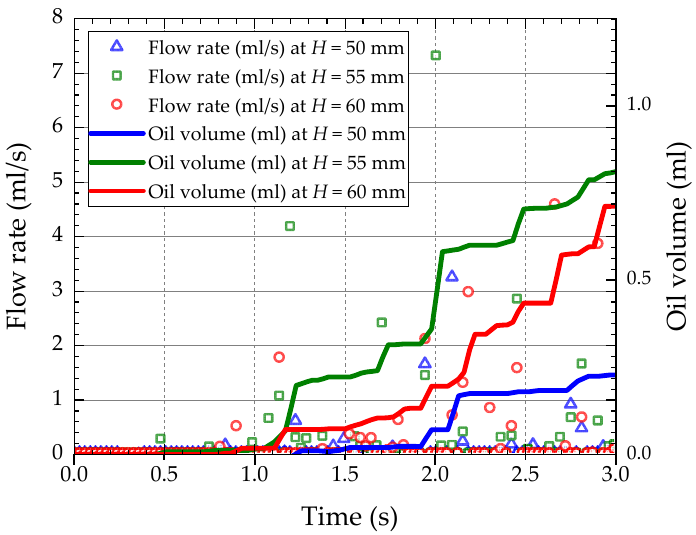
Figure 15. Change rules of flow rate and oil volume versus time (Monitoring Plane 1).